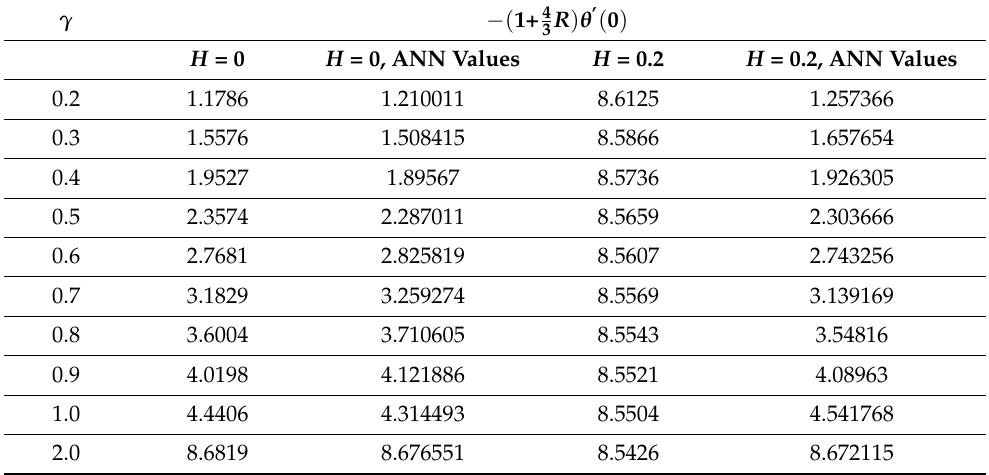
Table 5. Impact of curvature fluid parameter on Nusselt number with and without heat generation.